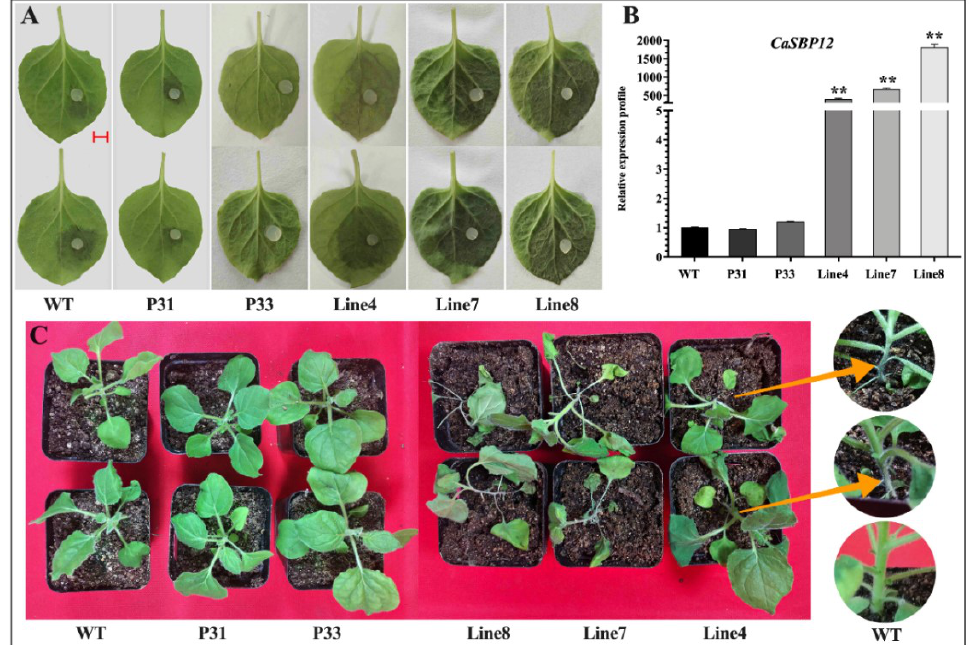
Figure 9. Phenotypes of the wild-type (WT), empty vector (P31, P33) and transgenic lines (line 4, line 7, and line 8) after inoculation with P. capsici and the expression of CaSBP12 in the transgenic, empty vector, and wild-type lines of N. benthamiana . ( A ) Phenotypes of the detached leaves of transgenic, empty vector, and wild-type lines after inoculation with P. capsici. ( B ) The expression of CaSBP12 in the transgenic, empty vector, and wild-type lines of N. benthamiana. The expression levels were analyzed between the transgenic lines (line 4, line 7, and line 8) and the wild-type (WT). ( C ) Phenotypes of the transgenic, empty vector, and wild-type (WT) lines after inoculation with P. capsici . The yellow arrows indicate the constricted area of the stem. Forty-five-day-old N. benthamiana plants were used for this experiment. The red line used as a scale bar (length 0.4 cm). The diameter of the plug of P. capsici used in this experiment is 0.4 cm. The diameter of the pot in Figure 9C is 7 cm. The means were analyzed using the least significant difference (LSD). Double asterisks (**) represents highly significant difference at p ≤ 0.01. Mean values and SEs for three replicates are